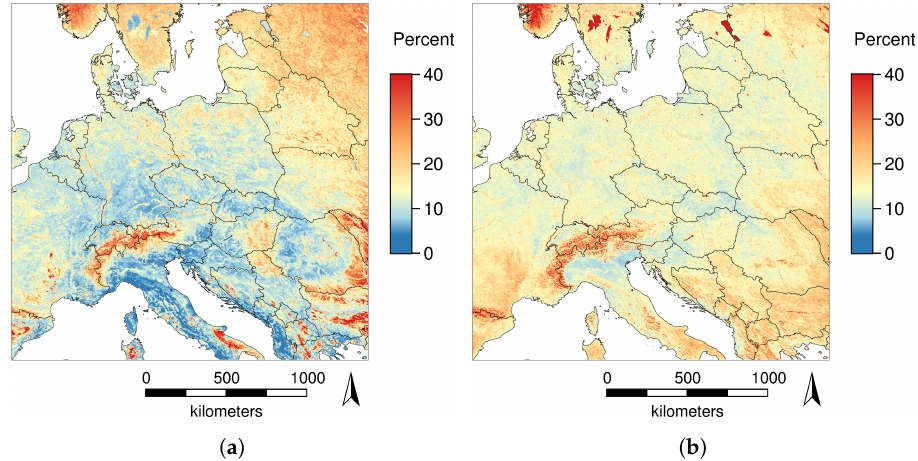
Figure 6. Percentage of LST outliers aggregated for each overpass time of day over all days and years: ( a ) at 01:30, 6.1% outliers; and ( b ) at 13:30, 5.7% outliers.